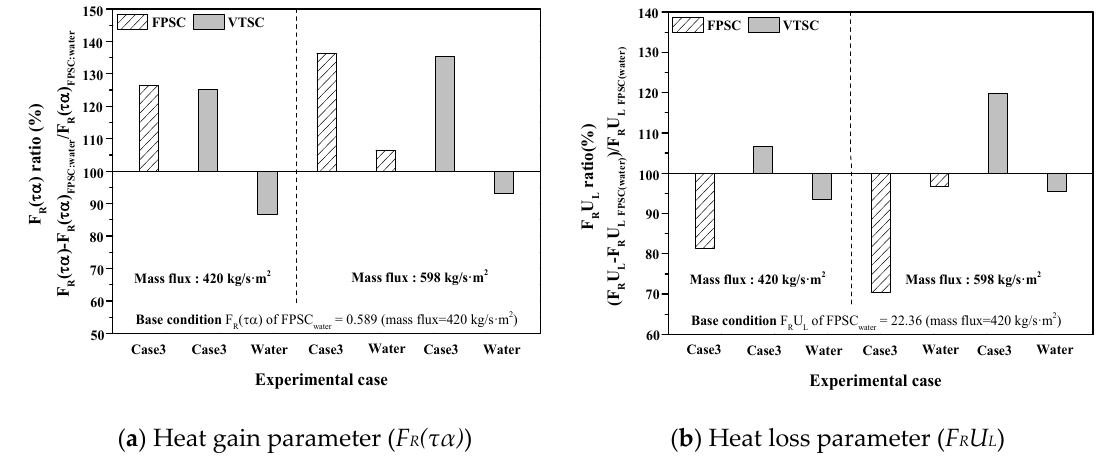
Figure 9. F R ( τα ) and F R U L ratio at different mass fluxes of water and MWCNT/Fe 3 O 4 nanofluid.